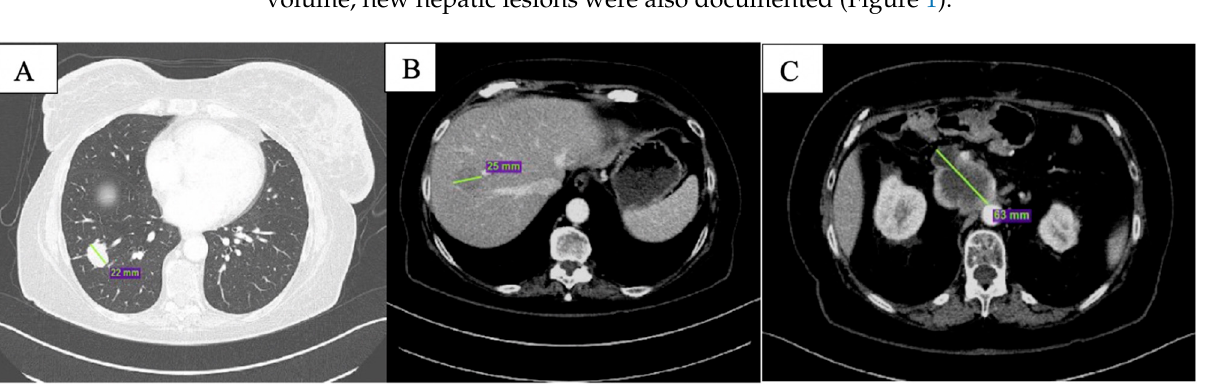
Figure 1. Baseline CT scan showing nodular lesion in inferior lobe of the right lung ( A ), hepatic lesion in the 8th segment ( B ) and peripancreatic tissue ( C